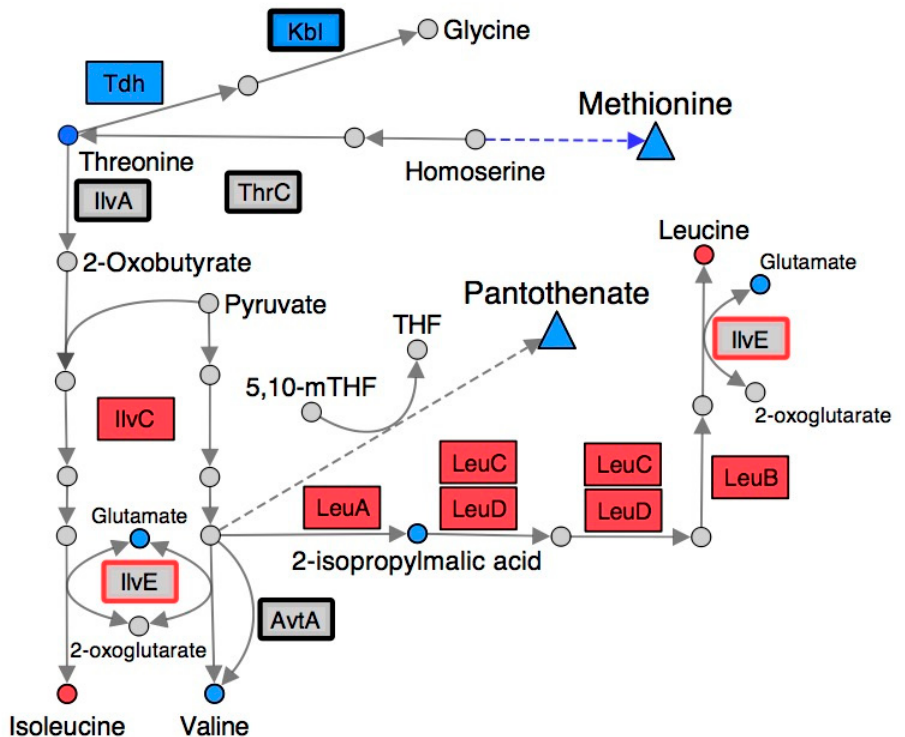
Figure 3. Gene expression and metabolite abundance in branched chain amino acid metabolism are altered in a S. enterica ridA mutant. Metabolites and gene products involved in branched-chain amino acid biosynthesis are shown using circles and rectangles, respectively. Blue shading represents significantly (FDR < 0.05) increased abundance of the respective metabolite / transcript in ridA cells, while red shading indicates significantly decreased abundance in ridA cells. Grey gene products showed no significant difference between wild-type and ridA cells, while grey metabolites were either not identified or not significantly altered. A bold border around a gene product denotes enzymes that use PLP as a cofactor. IlvE (red border) is a known target for 2AA damage. Dashed arrows and triangles indicated general pathways that utilize the metabolite at the base of the arrow.